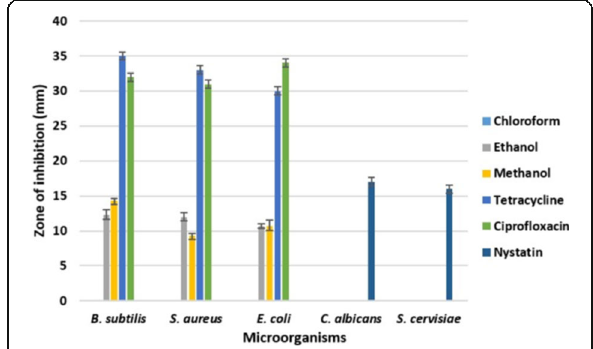
Fig. 2 Antimicrobial activity of crude extracts of O. ferruginea (stem bark) compared to antibiotics